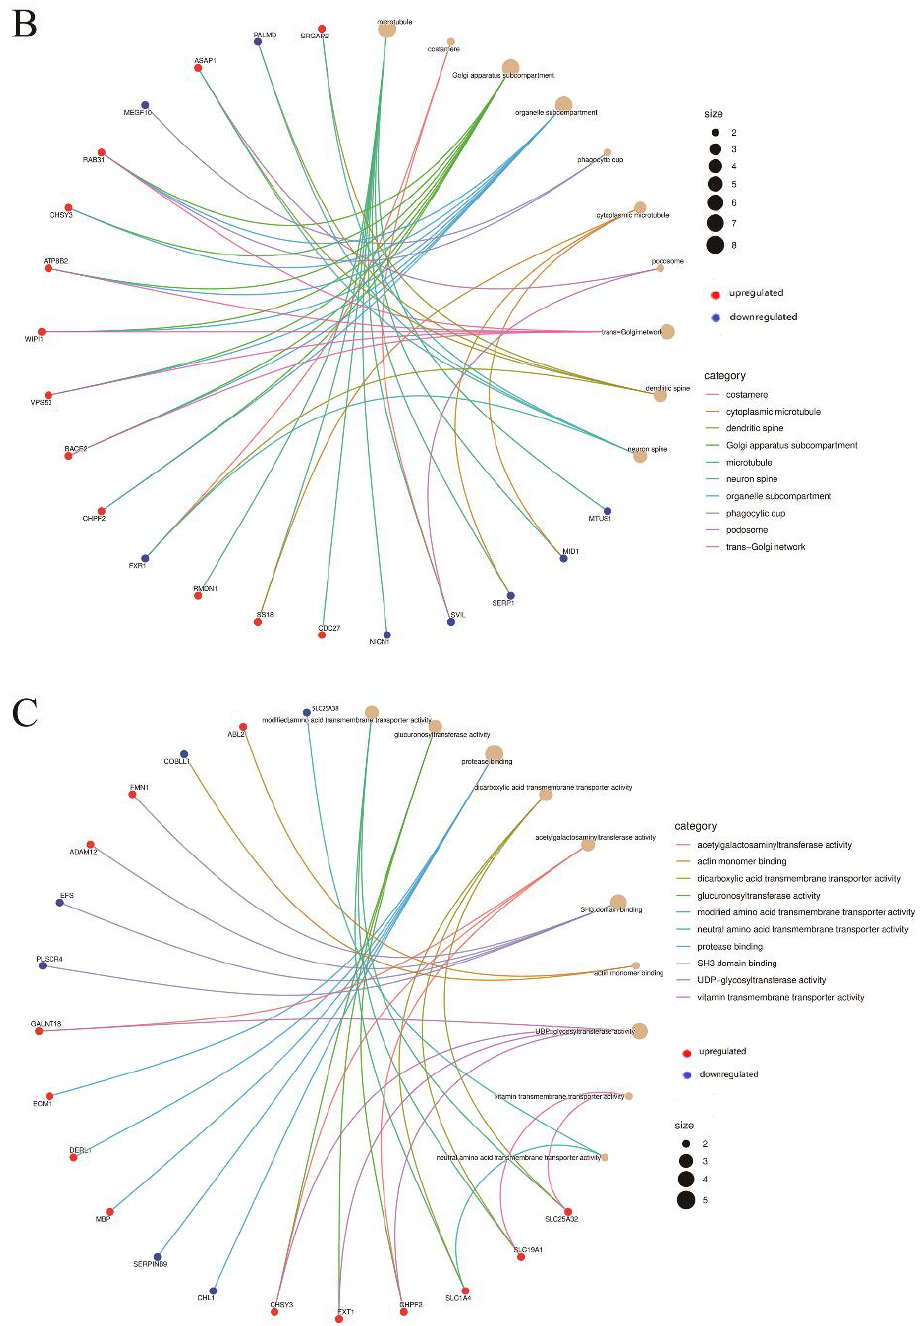
Figure 2. Gene Ontology (GO) enrichment analysis of differentially expressed genes (DEGs). Cnetplot shows GO enrichment significance items of DEGs in three functional groups: ( A ) molecular function (MF), ( B ) biological processes (BP) and ( C ) cell composition (CC). Symbols of DEGs are presented on the left side of the graph. Symbols in red represent upregulated genes, and blue represents downregulated genes. Gene involvement in the GO terms is indicated by colored connecting